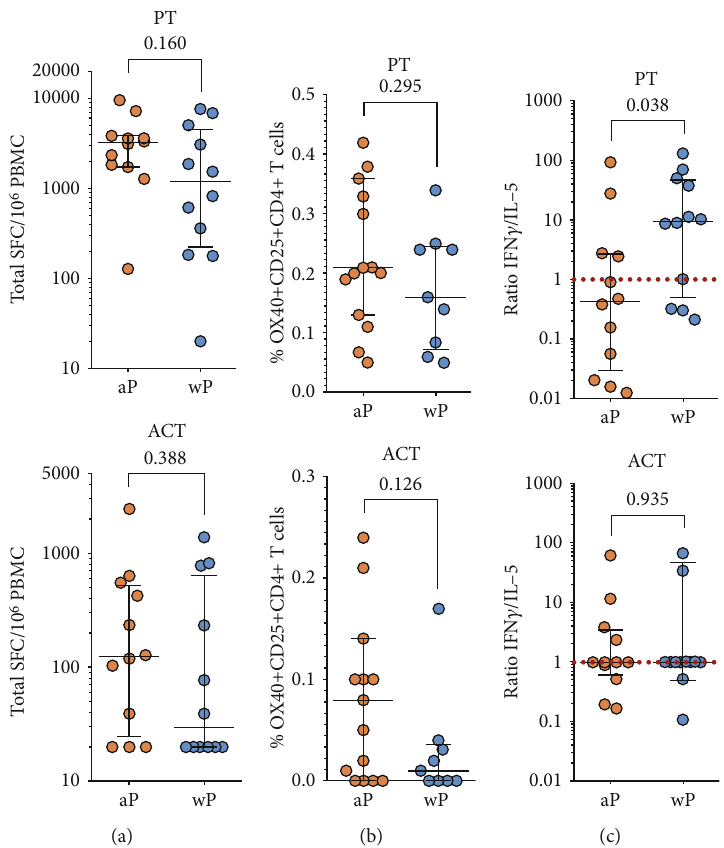
Figure 1: Original childhood aP priming is associated with high reactivity to pertussis antigens. (a) Cytokine production was measured by ELISpot following in vitro restimulation with BP lysate. Magnitude of responses expressed by spot-forming cells (SFC) is shown for the sum of T cell responses (IFN γ , IL-5, IL-17, and IL-9) for all aP antigens (PT) or ACT between wP- and aP-primed donors ( n = 12 for aP and n = 12 for wP cohorts). (b) % of BP-speci fi c CD4+ memory T cells for PT or ACT antigens by AIM assay for donors originally primed with wP or aP vaccine ( n = 15 for aP and n = 9 for wP cohorts). (c) Di ff erential polarization of T cell responses for PT but not ACT. Each data point represents the ratio of IFN γ /IL-5 SFCs from each donor ( n = 12 for aP and n = 12 for wP cohorts). Data are expressed as median ± interquartile range for each cohort with the Mann – Whitney U test comparison